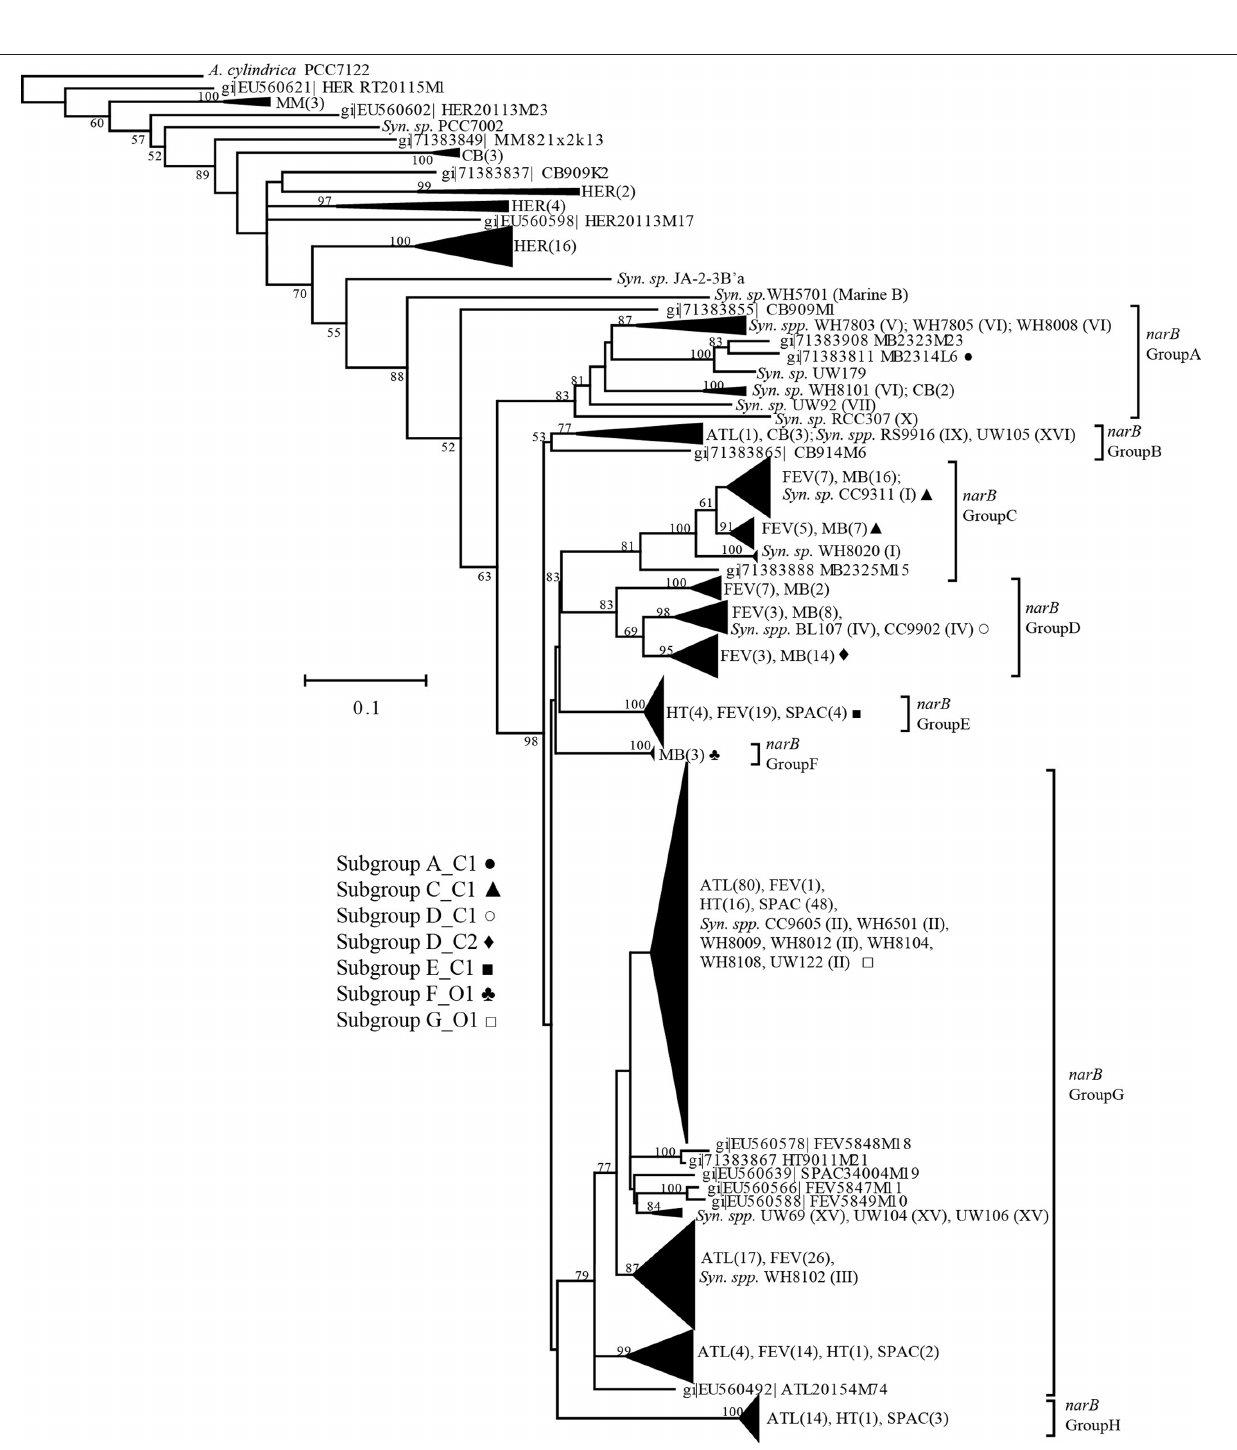
regions of the tree. Synechococcus isolates that have been classified into a major Synechococcus clade (e.g., based on the 16S rRNA gene, ITS, rpoC ) are marked with their respective clade numeral. GenBank accession numbers for sequences within narB clusters have been omitted for brevity, but are listed in Paerl et al. (2008). GenBank ID’s for the narB sequences of Synechococcus isolates are included in Table A2 in Appendix. narB qPCR assay names are in bold text next to identifier symbols, and corresponding symbols are next to targeted clusters of the